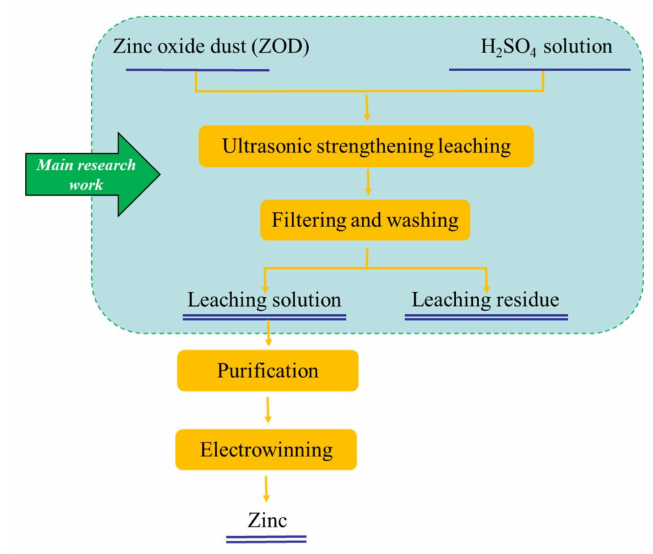
Figure 5. Flow diagram of the leaching process for